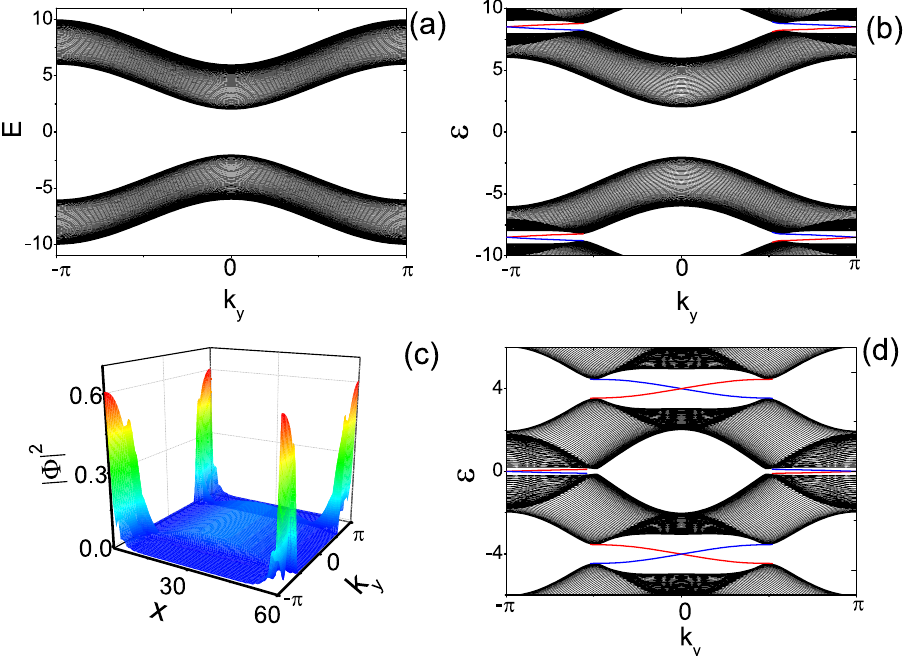
Figure 1. The edge states of Flouqet topological superfluid. ( a ) The spectrums of undriven systems H ( k ) given by Eq. (4) for μ = − 2, J 0 = 1 and Δ = 1 in a strip geometry. ( b ) The spectra of the Floquet Hamiltonian given by Eq. (7) in a strip geometry, with μ = − 2, J 0 = 1, J D = 0.9, Δ = 1, and ω = 17. ( c ) The wave function | Φ | 2 of the edge states in ( b ). The pair chiral edge states are localized at two boundaries respectively. ( d ) The spectra of the Floquet Hamiltonian in a strip geometry, with μ = − 2, J 0 = 1, J D = 0.9, Δ = 1, and ω =